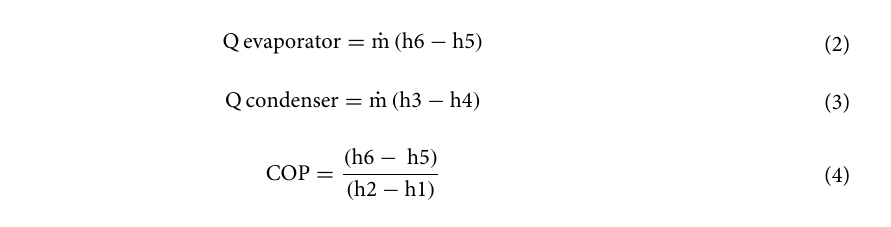
Figure 3. The cycle of the experiment on the P–h